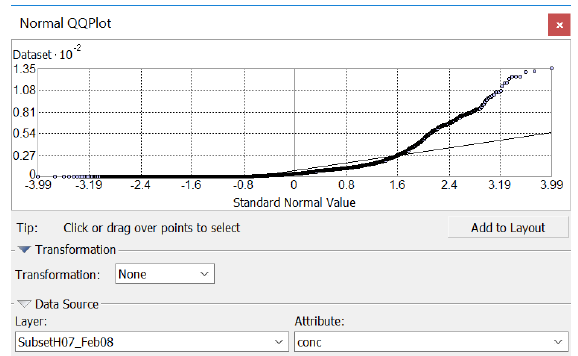
Figure 6. Normal QQPlot for daytime hour (6AM-7AM)